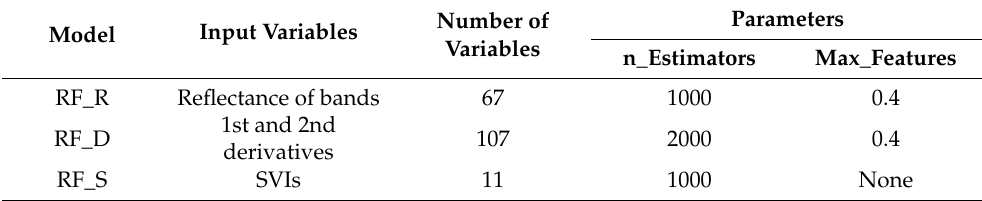
Table 3. Parameters of the RF models with different input